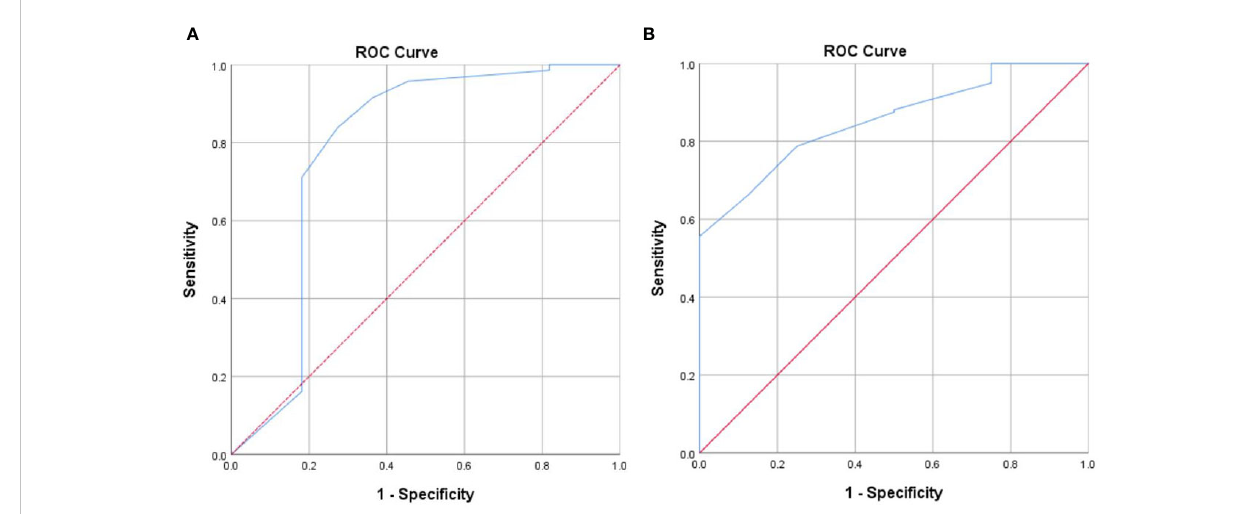
FIGURE 2 (A) Receiver operating characteristic curve of the distress thermometer score against the Hospital Anxiety and Depression Scales-Total cutoff score 15 for patients with stage III. (B) Receiver operating characteristic curve of the distress thermometer score against the Hospital Anxiety and Depression Scales-Total cutoff score ≥ 15 for patients with stage IV.